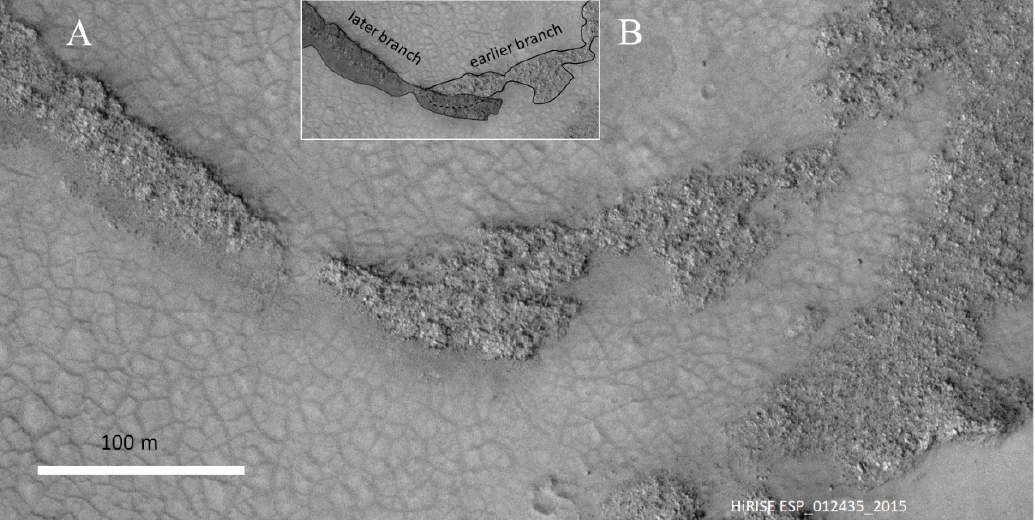
Figure 13. ( A ) Detail from Figure 12 showing the superposition between two different dendritic branches. ( B ) The interpreted order of superposition.